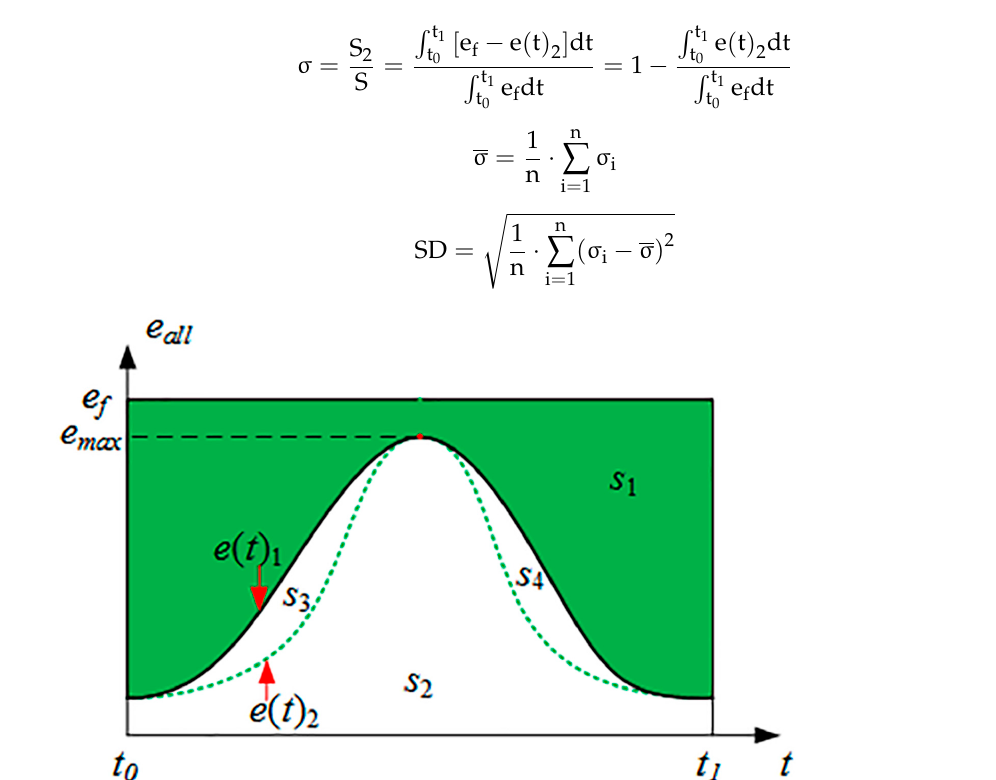
Figure 3. Geometric diagram of the effective tracking factor of an SDC system [29].